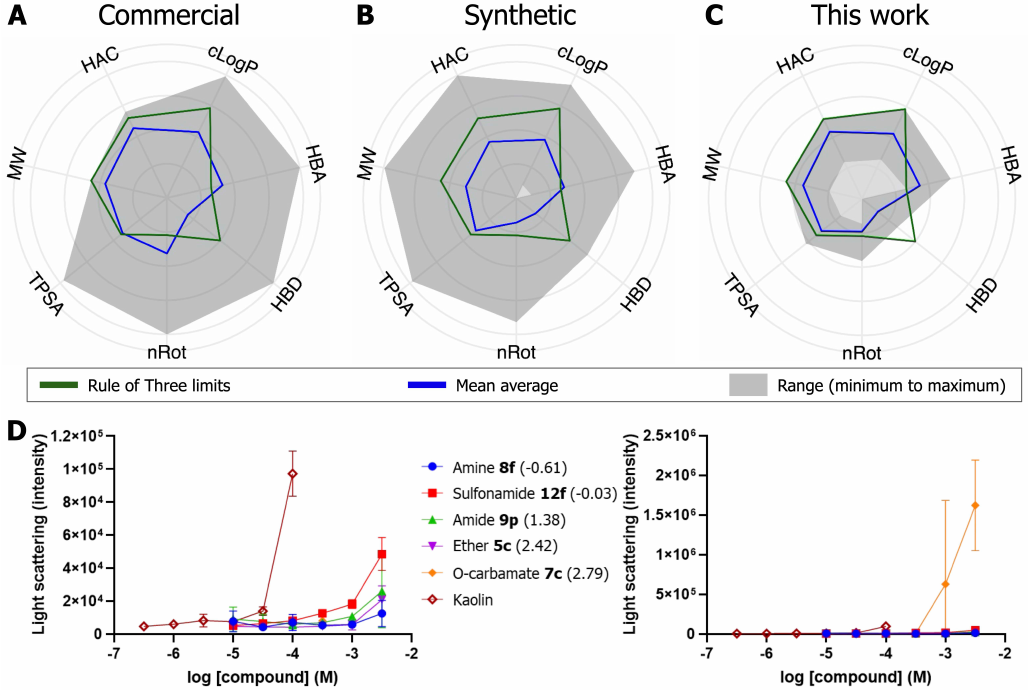
Figure 3. Physicochemical properties. ( A – C ) Distribution of calculated physicochemical properties of ( A ) Commercial “Fsp 3 ” and “3D” fragment libraries extracted from a recent review [39], ( B ) 25 papers disclosing synthetic 3D fragment sets [40], and ( C ) the 100 compounds of the current paper. Axes scaling was based on the limits of all three libraries ( A – C ) combined and axis values are as follows: cLogP: [ − 2.4; 5.0], HBA: [0; 9], HBD: [0; 6], nRot: [0; 11], TPSA: [0; 140 Å 2 ], MW: [95; 455 Da], HAC: [7; 27]). Values were calculated with KNIME software on the neutral chemical species. cLogP was calculated as SLogP. Mean average is depicted by the blue line. Ranges as defined by the minimum and maximum values are defined by the gray areas. The green line shows the “Rule of Three” limits (supplemented with a HAC limit of ≤ 20). ( D ) Nephelometry analysis of selected fragments and kaolin (control suspension) in HBSS buffer containing 1% DMSO. cLogD values are presented between brackets. Data points are the mean ± SD of values measured in triplo and normalized to kaolin control. Inflection points are considered to be a sign of aggregation and these are quantified using 3 times the SD of the average blank measurements. In the zoomed-in left panel, the 10 –3 and 10 –2.5 M points for 7c are omitted for clarity, while the right panel contains the full set of data